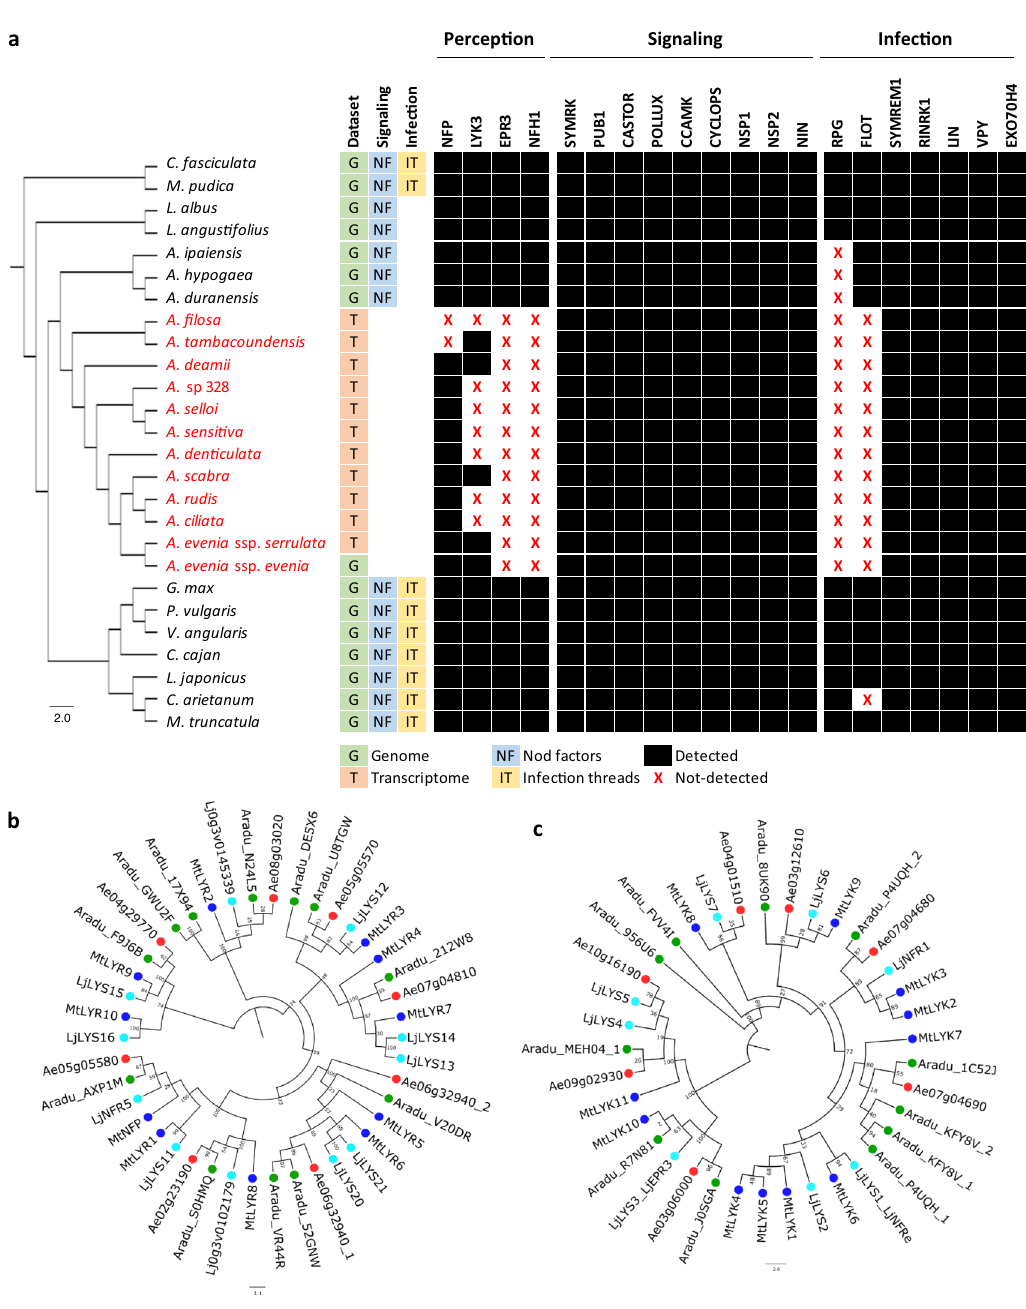
Fig. 2 Comparative analysis of symbiotic receptors, signaling, and infection genes. a Phylogenetic pattern of symbiotic genes involved in rhizobial perception, signaling, and infection. The phylogenetic tree containing Aeschynomene species (in red), members of the main Papilionoid clades, and two non- Papilionoid legume species was obtained by global orthogroup analysis. All bootstrap values (×1000) were comprised between 92% and 100% and so are not indicated for fi gure clarity. The presence and absence of genes are indicated in black or with a red cross, respectively. b , c Phylogenetic analysis of the LysM-RLK gene family in A. evenia (red), Arachis duranensis (orange), M. truncatula (blue), and Lotus japonicus (green). b Phylogenetic tree of the LYR genes. c Phylogenetic tree of the LYK genes. Node numbers represent bootstrap values (% of 1000 replicates). The scale bar represents substitutions per